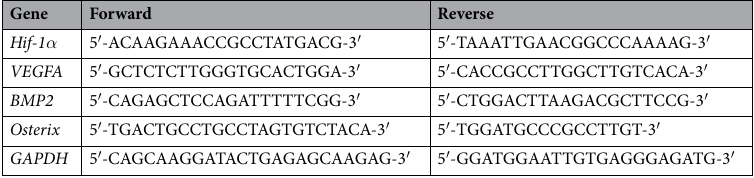
Table 1. Primer sequences for the detected